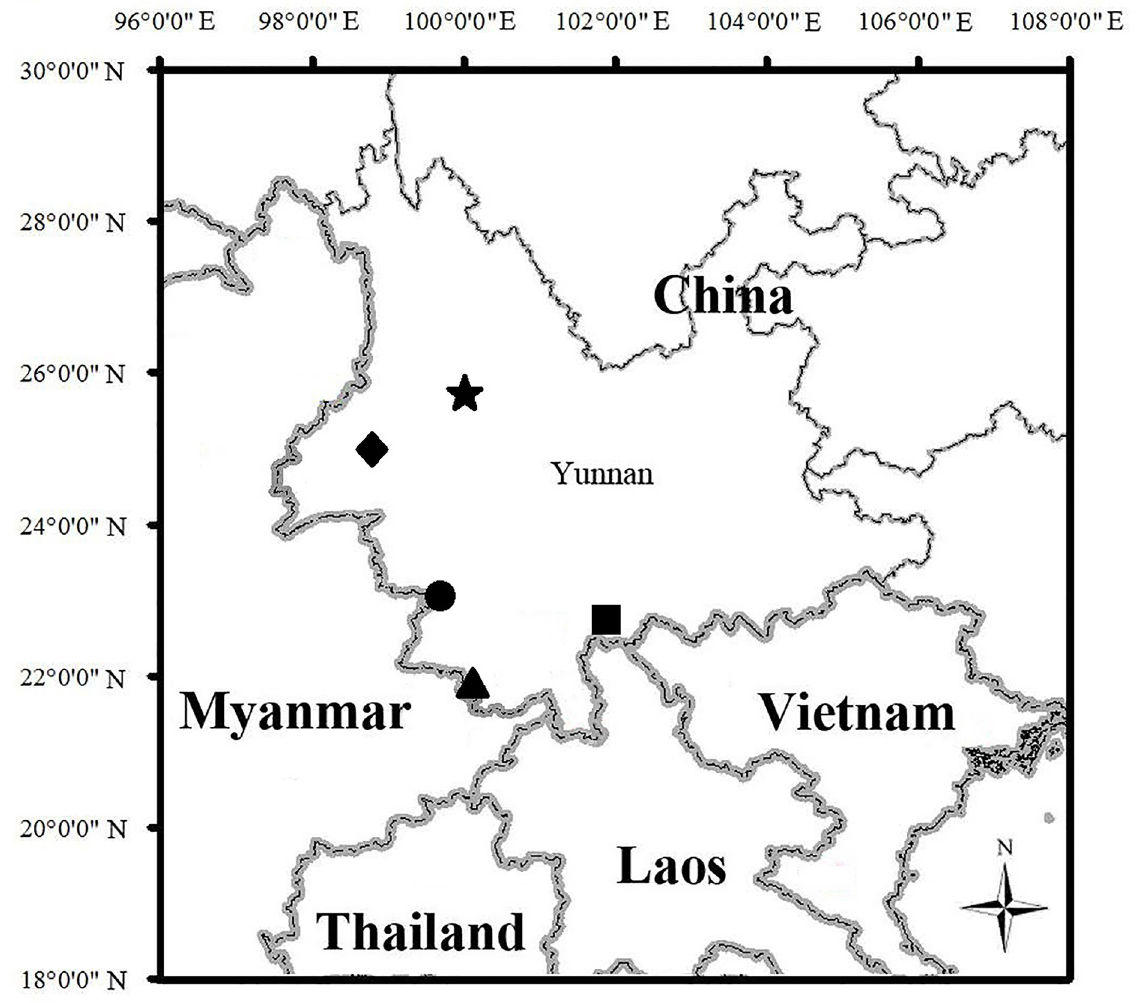
Fig. 8. Map showing the type locality of Pareas yunnanensis (Vogt, 1922) (black star), the type locality of P. geminatus Ding, Chen, Suwannapoom, Nguyen, Poyarkov & Vogel, 2020 (black square), the type locality of P. xuelinensis Liu & Rao, 2021 (black circle), the type locality of P. nigriceps Guo & Deng, 2009 (black diamond), and the type locality of P. tigerinus sp. nov. (black